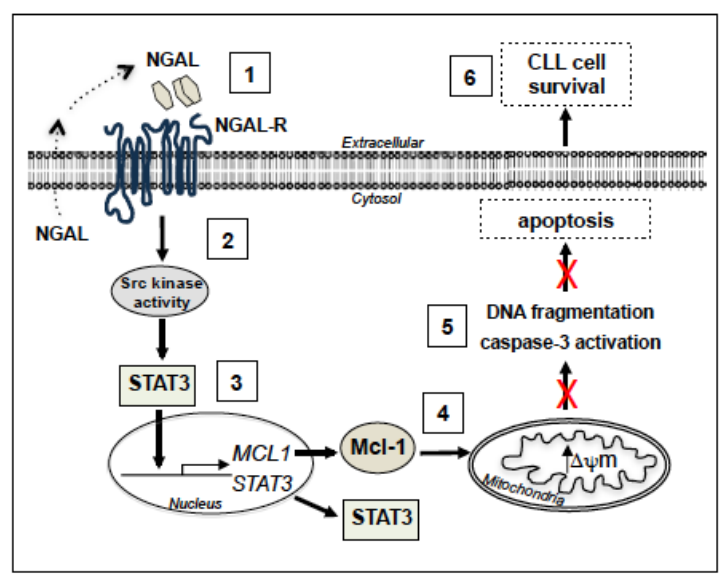
Figure 8. Putative model for the involvement of cell signaling pathways in the induction of survival by NGAL in CLL cells. By binding to surface NGAL-R ( 1 ), NGAL (dimers and monomers) likely leads to the activation of an Src family kinase ( 2 ), which, in turn, activates STAT3. STAT3 dimer enters the nucleus and binds the promoters of STAT3 and MCL1 ( 3 ). Following STAT3 and MCL1 transcription, STAT3 and Mcl-1 proteins accumulate in the cytoplasm, and Mcl-1 exerts its anti-apoptotic activity by preventing mitochondrial depolarization ( 4 ), leading to the inhibition of caspase-3 activation and DNA fragmentation ( 5 ), ultimately favoring cell resistance to apoptosis ( 6 ). The dotted arrow suggests an autocrine NGAL stimulation loop for CLL cell survival.